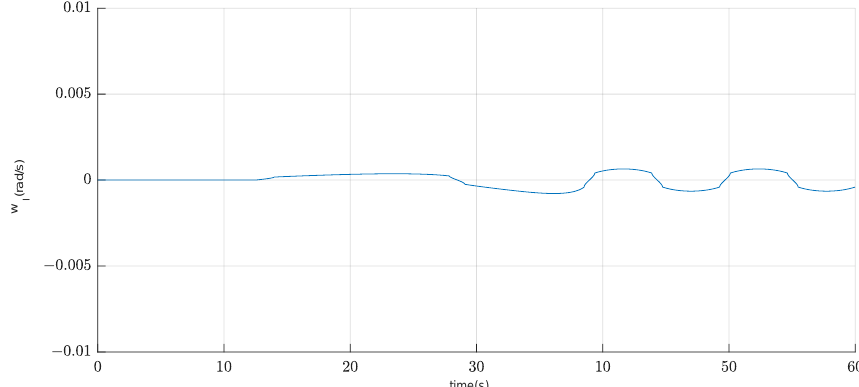
for the leader during the movement. 𝑣𝑣 𝑙𝑙